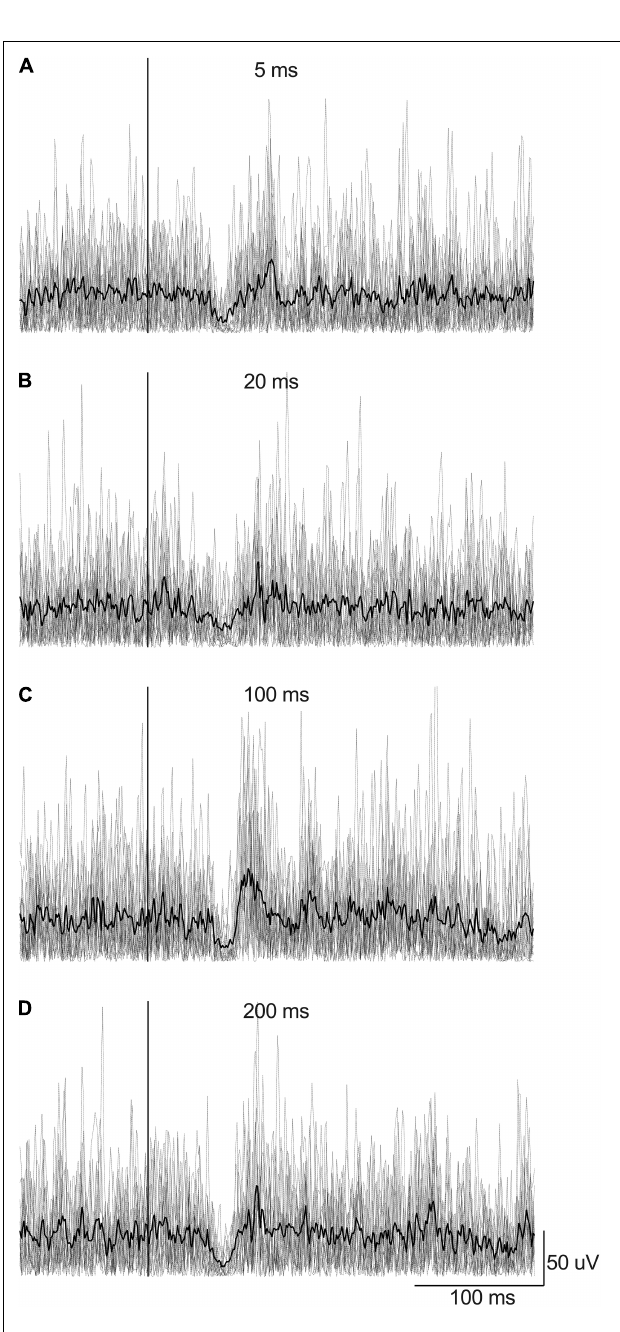
FIGURE 3 | Example of rectified EMG signals recorded from the right LES muscles from a participant according to EVS duration (EVS intensity was 4 mA with right head rotation): (A) 5 ms, (B) 20 ms, (C) 100 ms, and (D) 200 ms. Gray lines represent the EMG traces recorded for each 15 stimulations by condition whereas the black line represents the average EMG signal by condition. The stimulation is set at Time 0 (the vertical line).